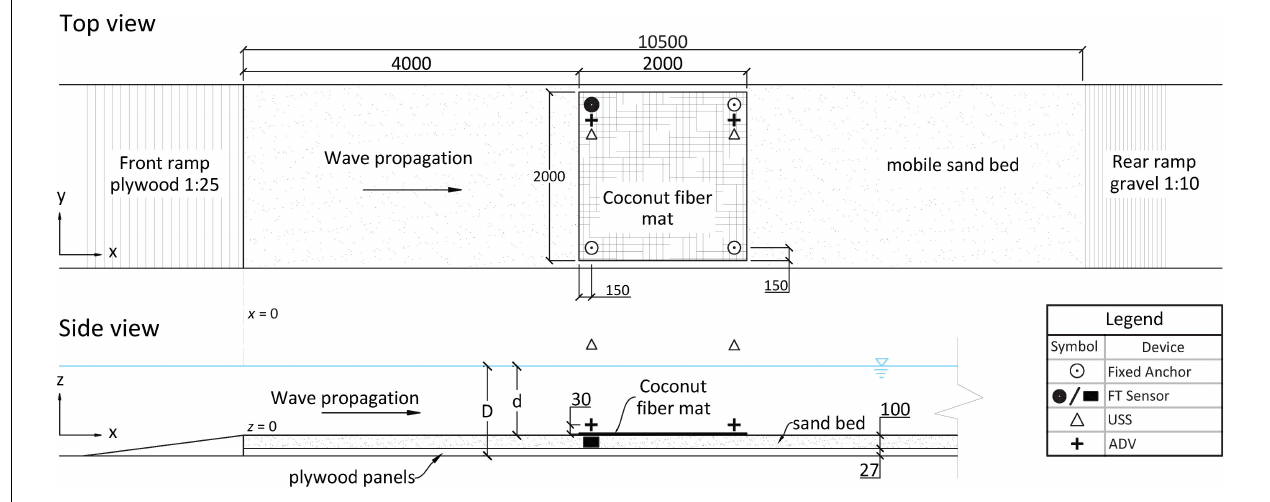
FIGURE 1 | Top and side view of the experimental set-up section of the flume. The wave paddle is located at x = –62.65 m. x = 0 position shown by the gray dashed line joining both schemes. The experimental set-up shown corresponds to the coir mat experiments without artificial seagrass (for one anchor set-up, see section “Coir Mat Tests”). The z -scale is exaggerated; all dimensions are given in mm. d = water depth above the sand bed; D = water depth above flume